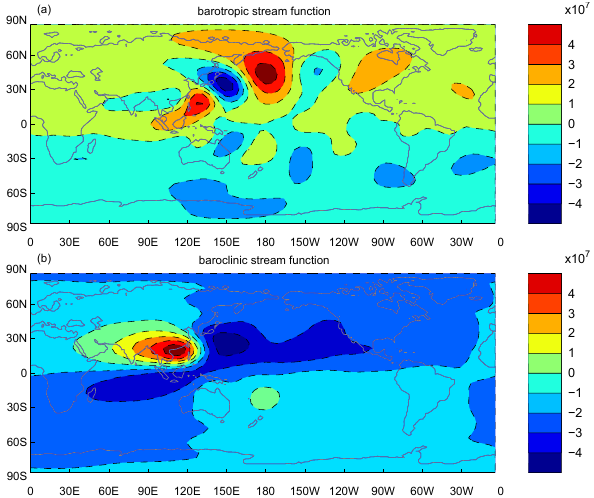
Figure 6. (a) Barotropic and (b) baroclinic stream function anoma- lies (units: 10 6 m 2 s − 1 ) for cases 1–4, with the black, red, green, and blue contours as stream function anomalies for cases 1, 2, 3, and 4, respectively. The contour interval is 2 × 10 6 m 2 s − 1